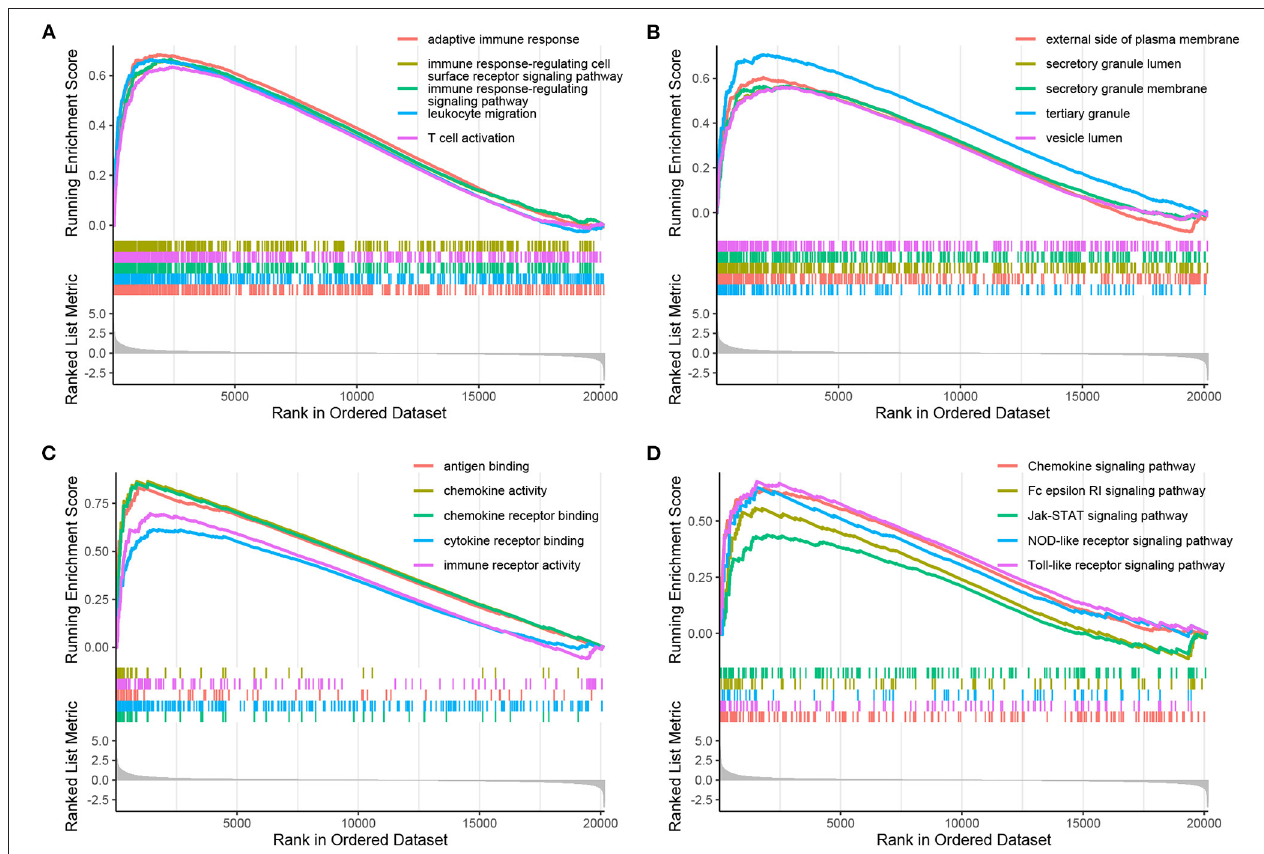
FIGURE 3 | Enrichment plots obtained by GSEA. The enriched gene sets for BPs (A) , CCs (B) , MFs (C) , and KEGG pathways (D) are shown.